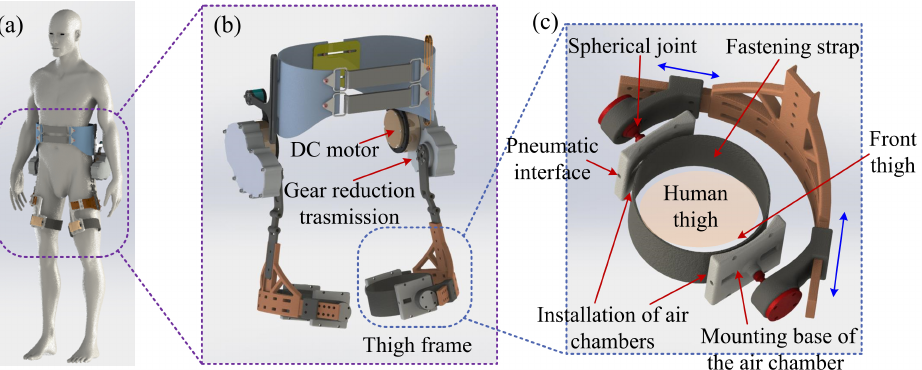
Figure 1. The 3D model of the hip joint exoskeleton and the soft sensor system. ( a ) The composition of the exoskeleton of the hip joint and the design of the wearing structure around the thigh. ( b ) The hip exoskeleton with soft sensors. ( c ) The designed adjustable thigh frame and installation of the developed soft sensor